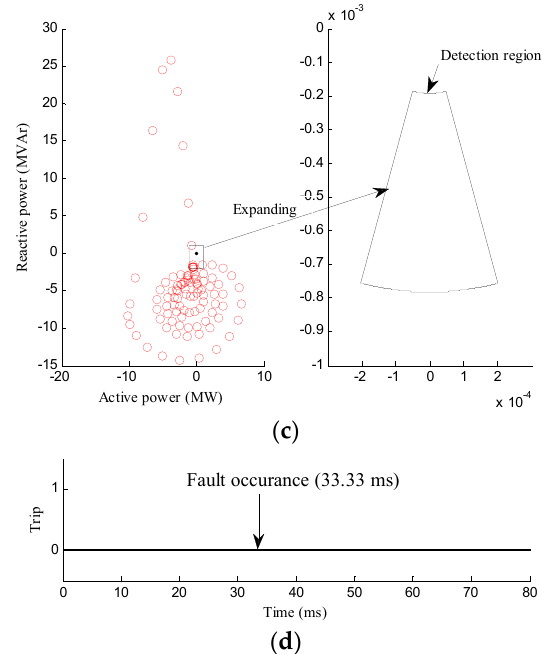
Figure 10. Results for Case 8. ( a ) v a , b , c (upper) and i a , b , c (lower); ( b ) p 3 ph (upper) and q 3 ph (lower); ( c ) Trajectories of the point ( p 3 ph , q 3 ph ); ( d ) Islanding detection signal.